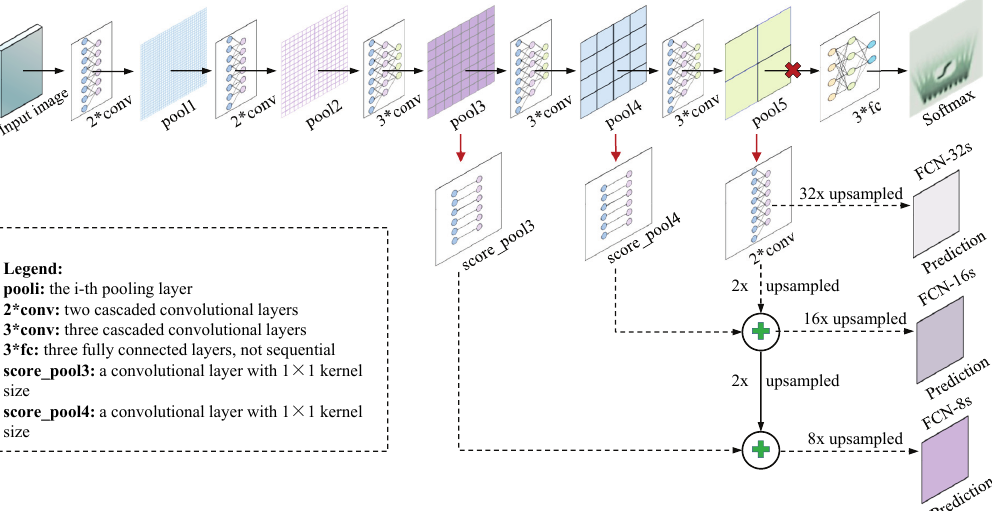
Figure 2. Architectures of fully convolutional